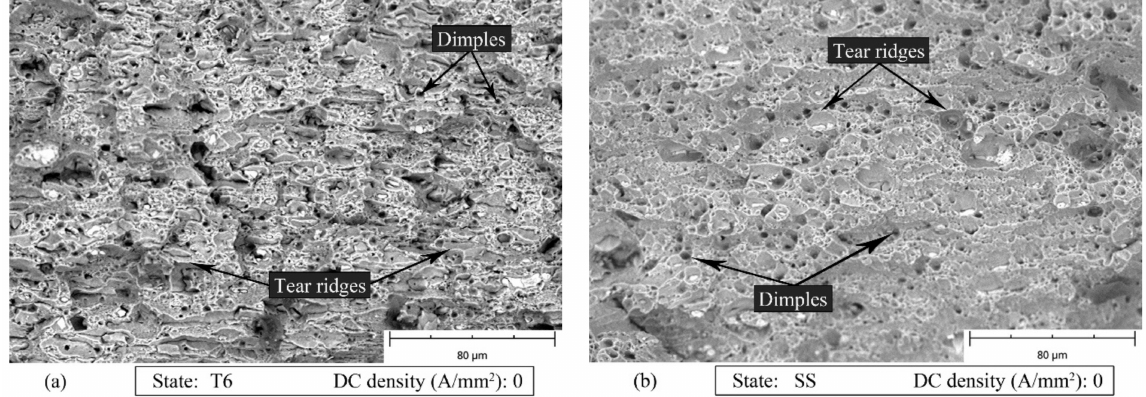
Figure 12. SEM fracture surfaces of the specimen strained without current application for the AA7075-T6 ( a ) and SS ( b ) states.